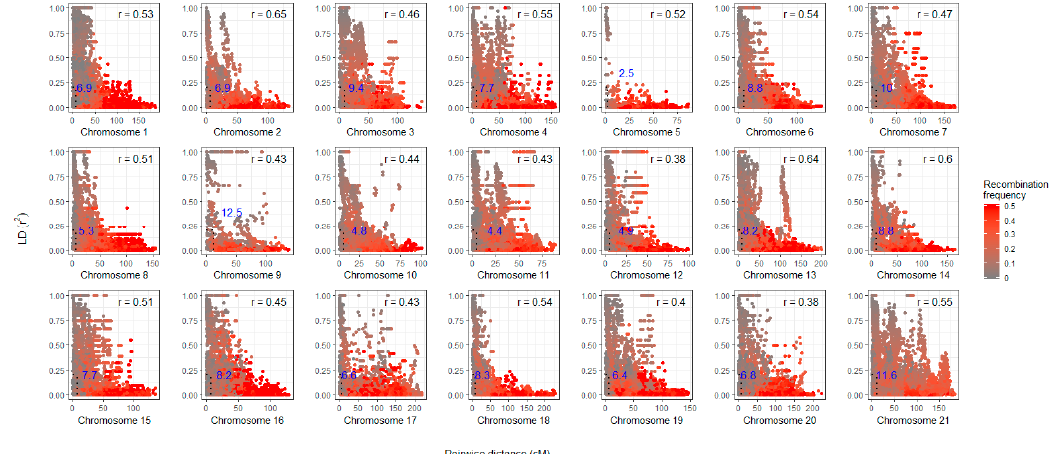
Figure 3. Pairwise linkage disequilibrium ( r 2 ) and recombination frequencies among SNP markers in each chromosome in the IWG F 1 mapping population A77-3 × C20-7. X-axis shows the pairwise SNP distances in centiMorgans (cM), Y-axis shows the r 2 values, and the legend shows distribution of recombination frequency values. Correlation coefficient between r 2 and recombination frequency, r , is shown on the top right of each plot. Blue text shows the decay distance when r 2 = 0.2.